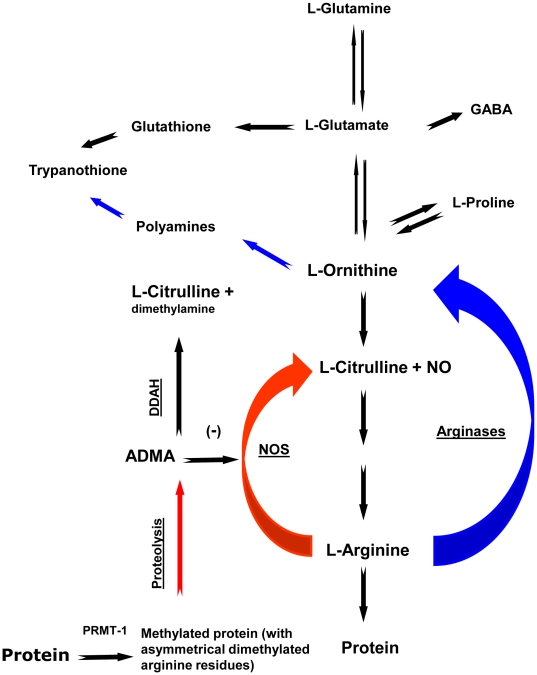
Simplified scheme of L-arginine pathways in mammalian host cells.L-arginine is a crossroad for multiple pathways since it is the common substrate of arginase and NOS that catalyzes the production of L-ornithine, L-citrulline and NO, respectively. ADMA, a product of the proteolysis of methylated proteins by PRMT-1, is a potent inhibitor of NOS. Its concentration is regulated by DDAH that catalyzes the production of L-citrulline and dimethylamine. L-ornithine and L-glutamate serve as precursors of polyamines and glutathione. These two metabolites will be further utilized by the trypanosomes for the synthesis of trypanothione, an essential element protecting the parasites from free radicals. Abbreviations: NO, nitric oxide; NOS, nitric oxide synthase; ADMA, asymmetric dimethylarginine; DDAH, NG,NG-dimethylarginine dimethylaminohydrolase; PRMT-1, Protein arginine N-methyltransferase 1; GABA, γ-aminobutyric acid.